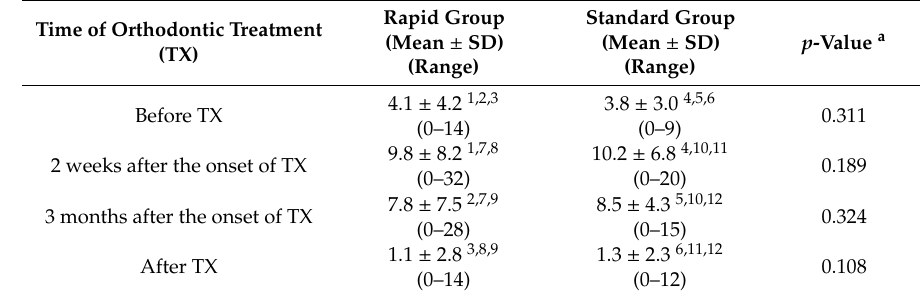
Table 4. The OHIP-14 Mean Total Score in the cancer survivors treated orthodontically according to the rapid and standard protocols before, during, and after orthodontic